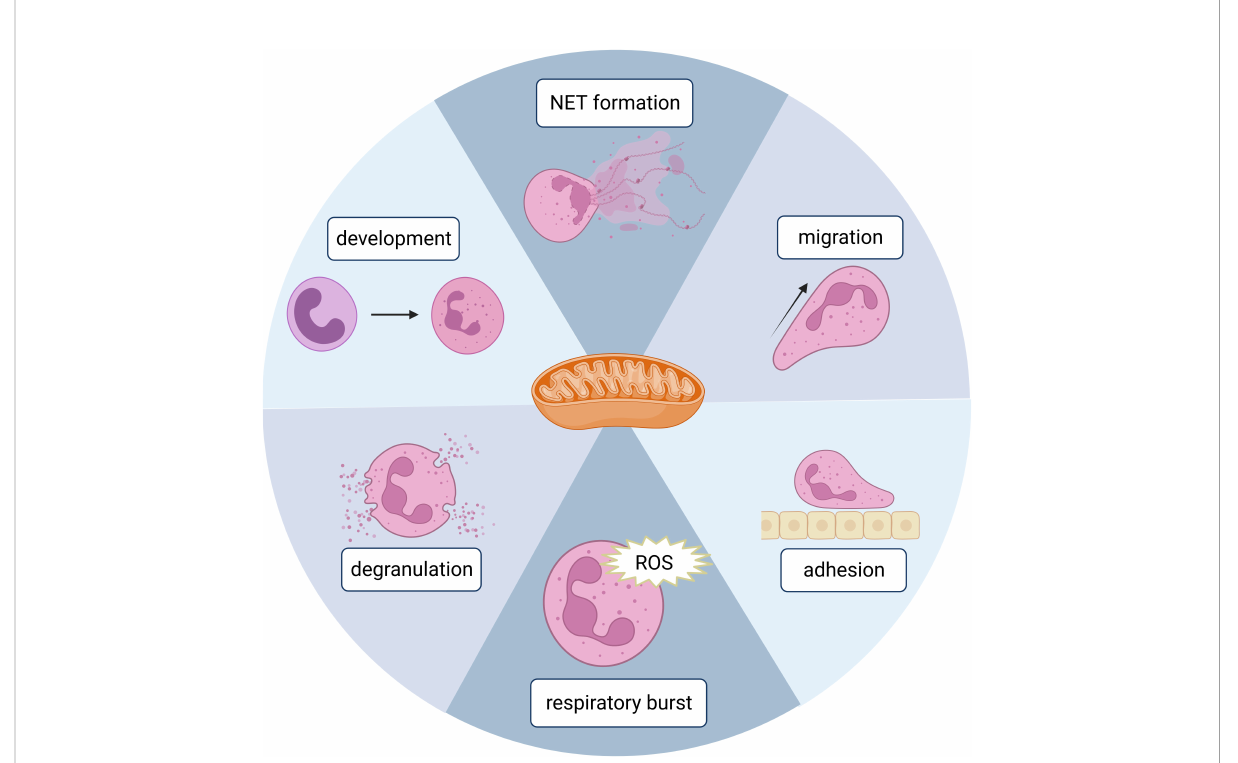
FIGURE 1 A schematic fi gure showing the involvement of mitochondria in different neutrophil functions. Created in